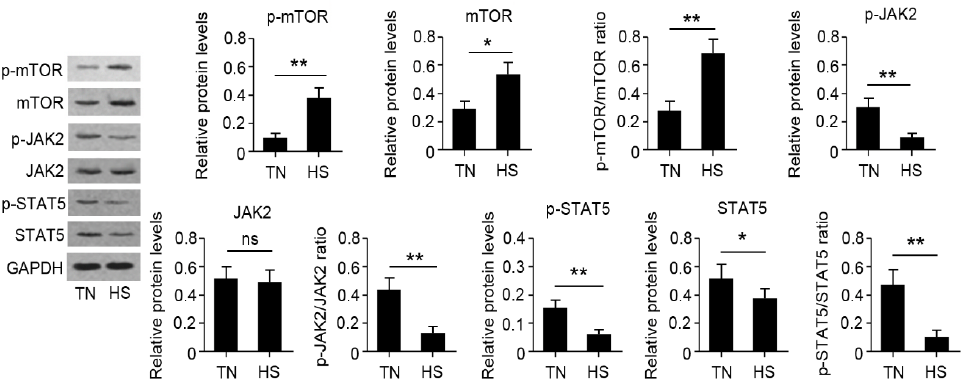
Figure 6. Identification of differentially expressed protein by Western blot assay (WBA). The WBA was carried out to find the protein and phosphorylation levels. * p < 0.05 or ** p < 0.01 vs. TN group. Ns: no significance.